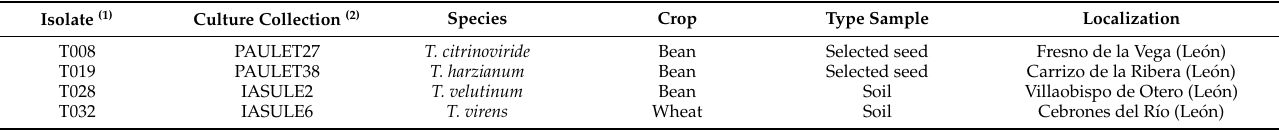
Table 1. Autochthonous Trichoderma strains used in this study.